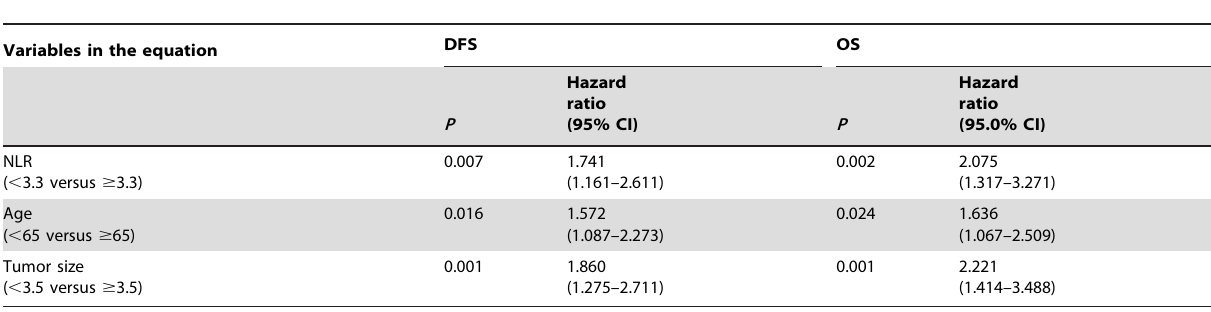
Table 4. Multivariate proportional hazards (Cox) regression analyses according to DFS and